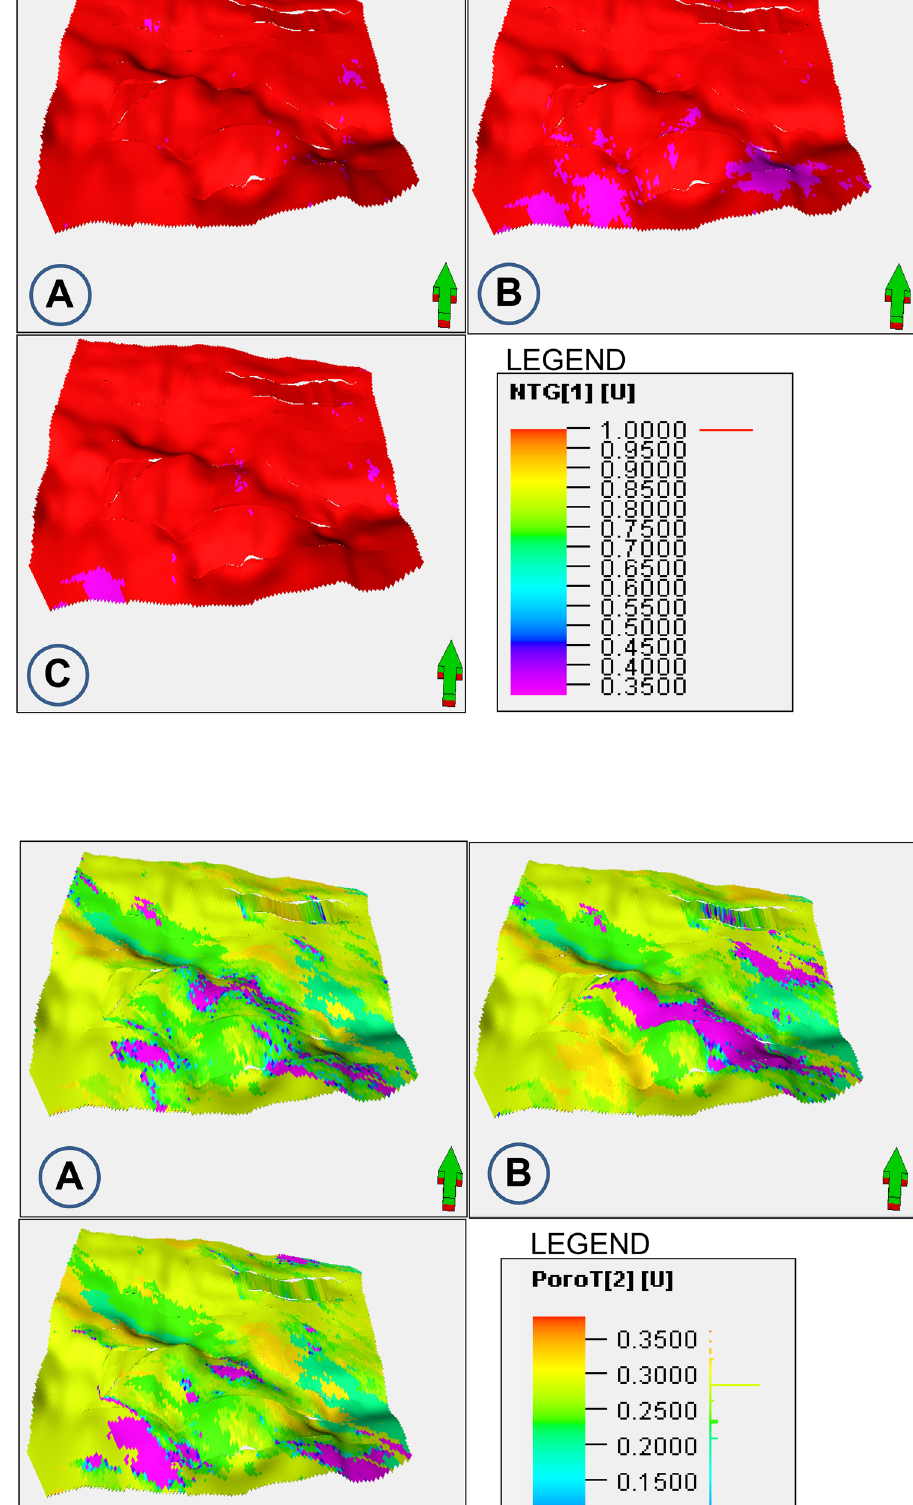
Fig. 10 Equiprobable realiza- tions of net-to-gross from K200 reservoir